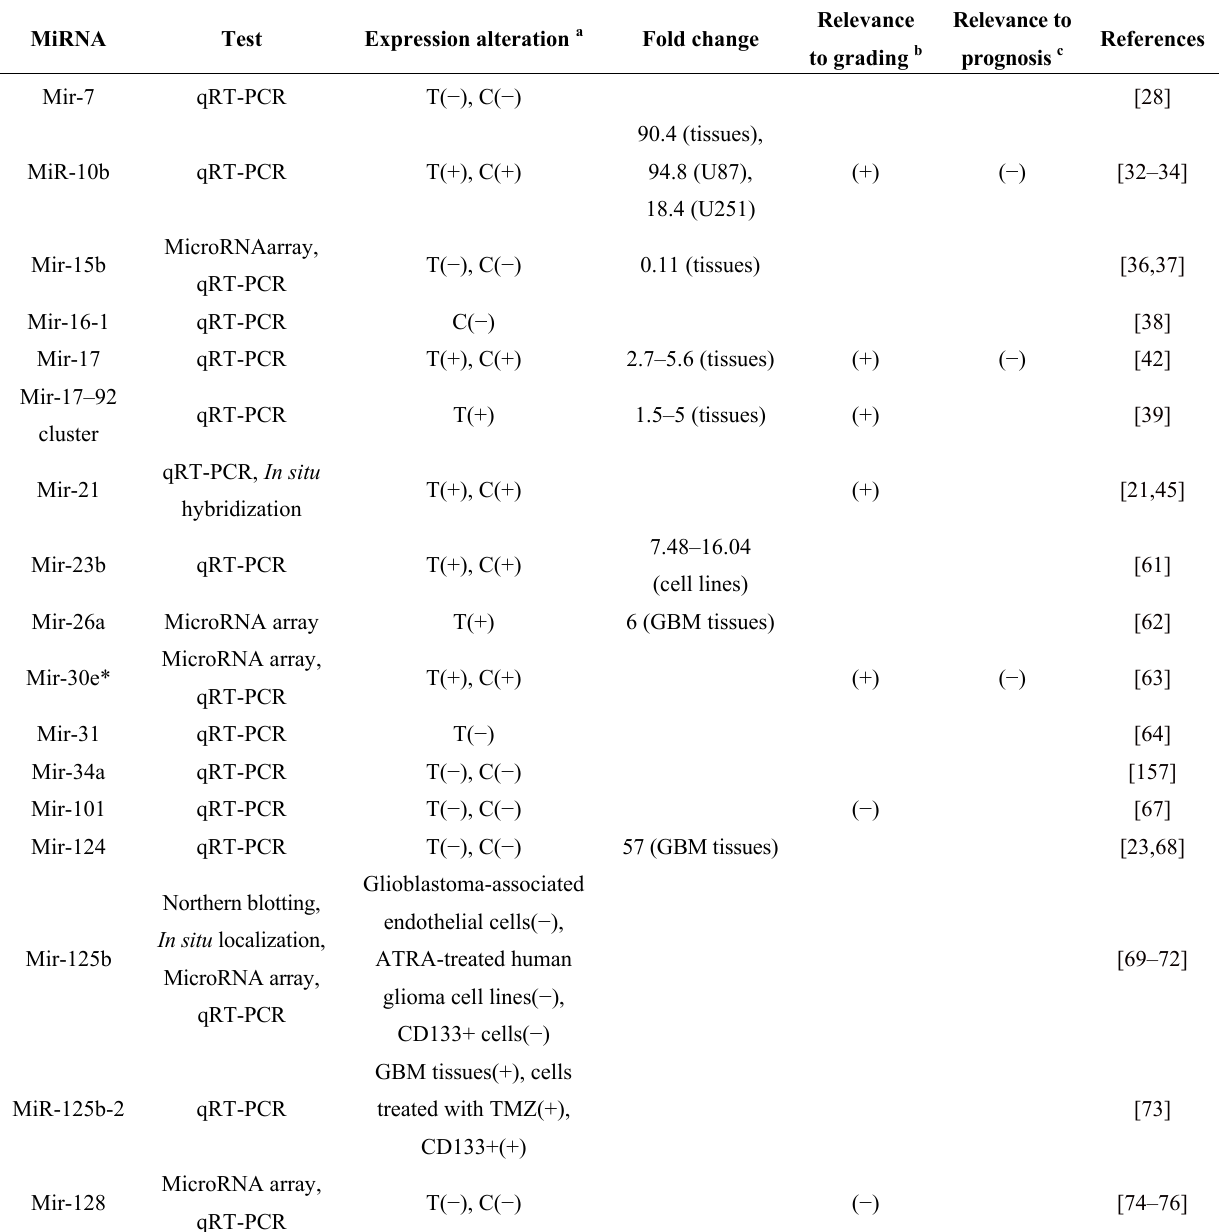
Table 2. MicroRNA expression in